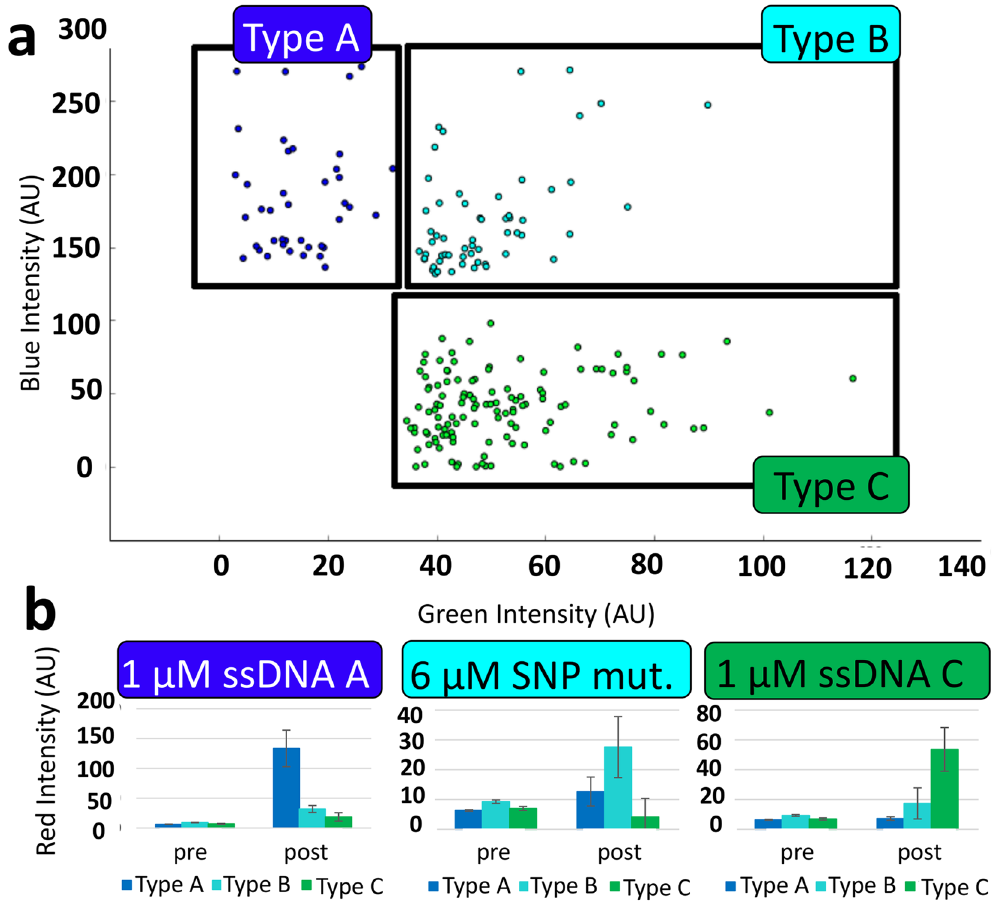
Figure 5. Results of automated image analysis using Python. ( a ) Images of particles are sorted according to their blue/green fluorescence. A scatter plot shows how the blue, green and teal particle data are sorted. ( b ) Red fluorescence intensity is graphed before and after adding the respective ssDNA. Error bars are the standard deviation of the mean of 9